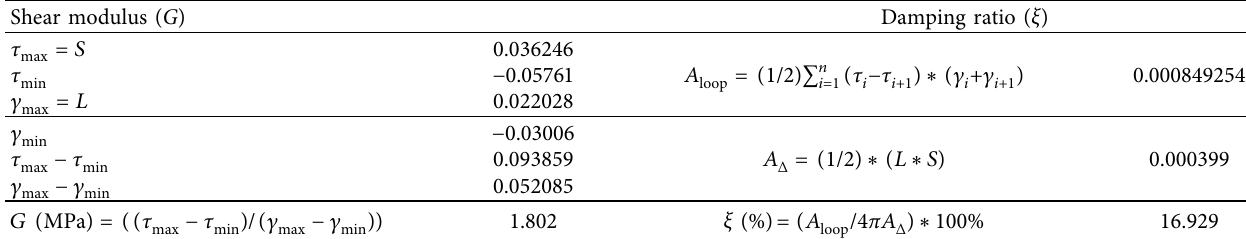
Table 4: Typical calculation of shear modulus and damping ratio of P @ 3m soil under 150kPa and the 5th cycle. Shear modulus ( G